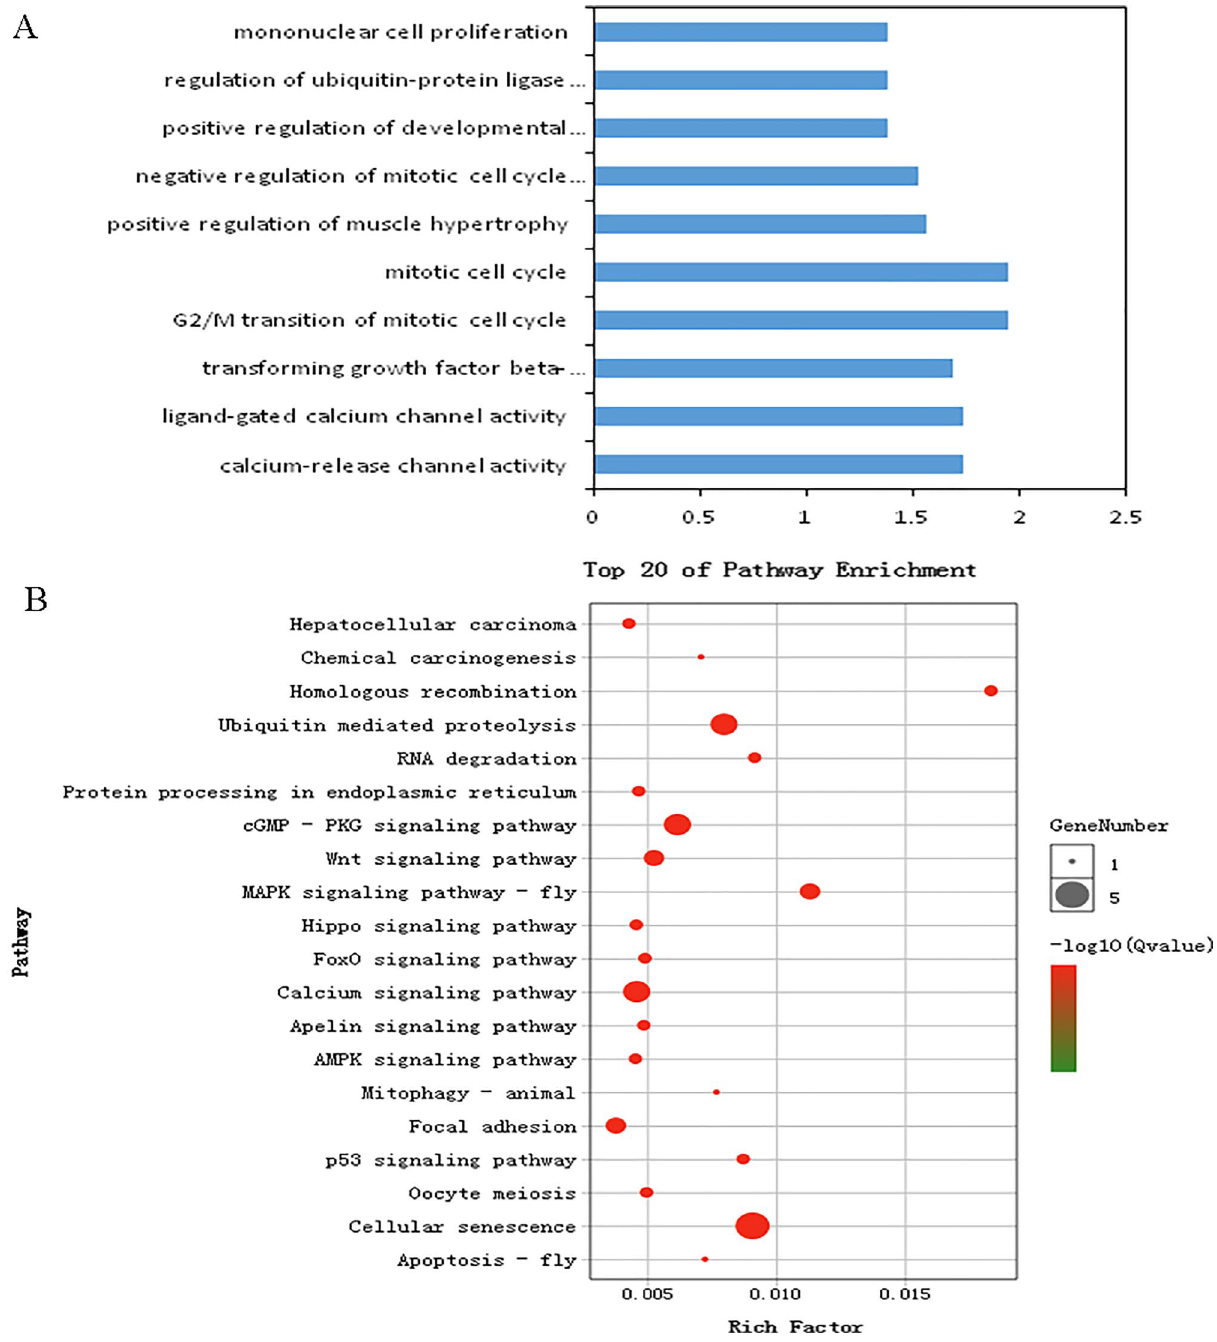
Figure 5. Functional enrichment analysis of differentially expressed host genes of circRNA between PMM and SART. ( A ) Gene Ontology (GO) terms and ( B ) KEGG pathways enriched for host genes of DE-circRNAs 43–45